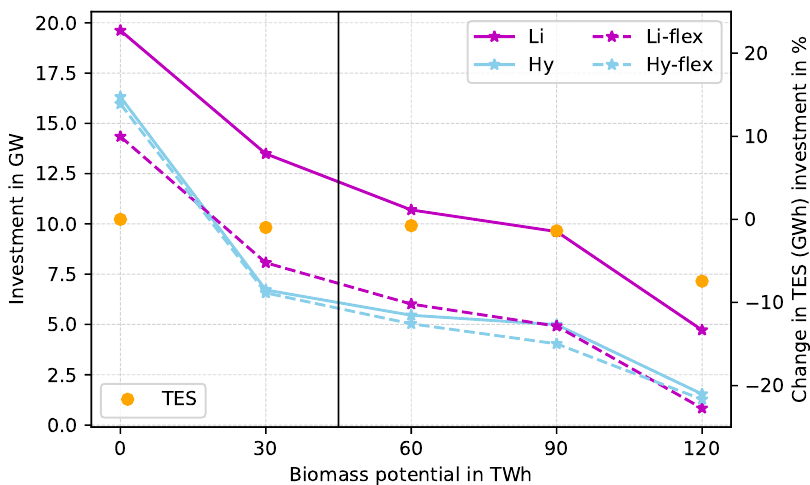
Figure 7. Sensitivity for installed storage capacities in GW in the 2050 scenario at different biomass potentials. Values for flexible heat pump operation are depicted as dashed lines. The 2050REF scenario is indicated by the vertical line inside the